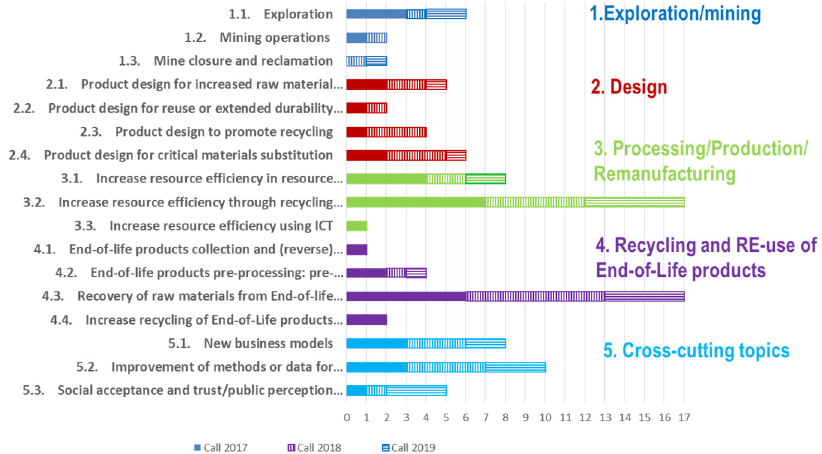
Figure 3. Sub call topics addressed by funded projects of the 2017, 2018 and 2019 JTCs in ERA-MIN 2. Please be aware that projects may address more than one